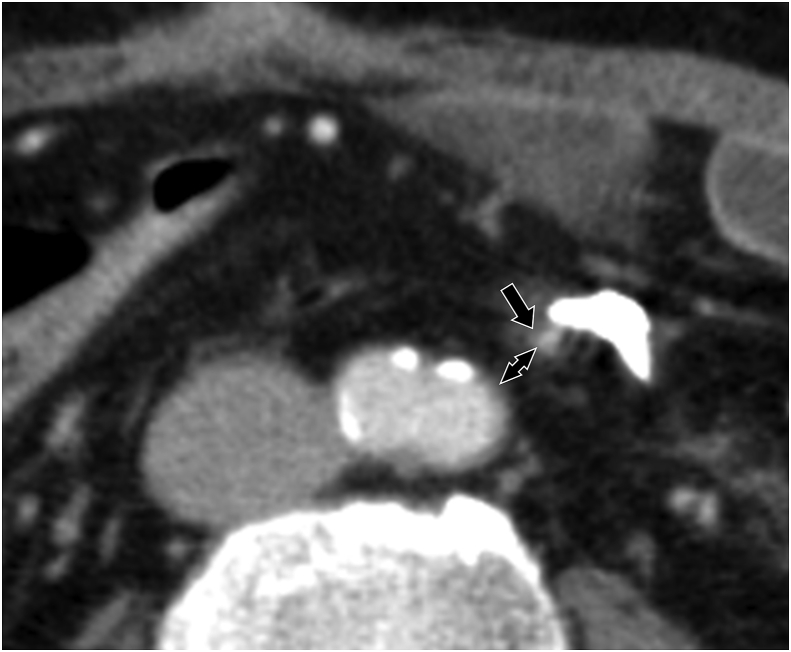
Distance between the superior rectal artery (SRA; arrow) and abdominal aorta at the aortic bifurcation level (double-headed arrow) was measured on computed tomography (CT) images obtained 3–6 months after SRA-preserving surgery.